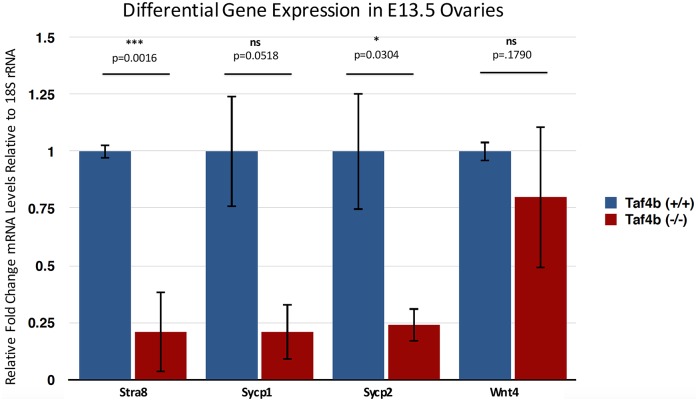
Reduced expression of meiosis genes in E13.5 Taf4b-deficient ovaries: Quantitative RT-PCR was used to compare differential gene expression between E13.5 wild-type and Taf4b-deficient ovary cDNA. RT-PCR was performed in technical triplicate and values were normalized to 18S rRNA with fold-change displayed after setting the wild-type value to 1.n = 4 wild-type animals and 3 Taf4b-deficient animals. Taf4b-deficient oocytes displayed about 25% of the Stra8, Sycp1, and Sycp2 mRNA expression of wild-type oocytes, while the somatic marker Wnt4 is not significantly changed between genotypes. Error bars represent SEM, and p-values were determined by Unpaired Student T-Test (* = p < 0.05; *** = p < 0.005).